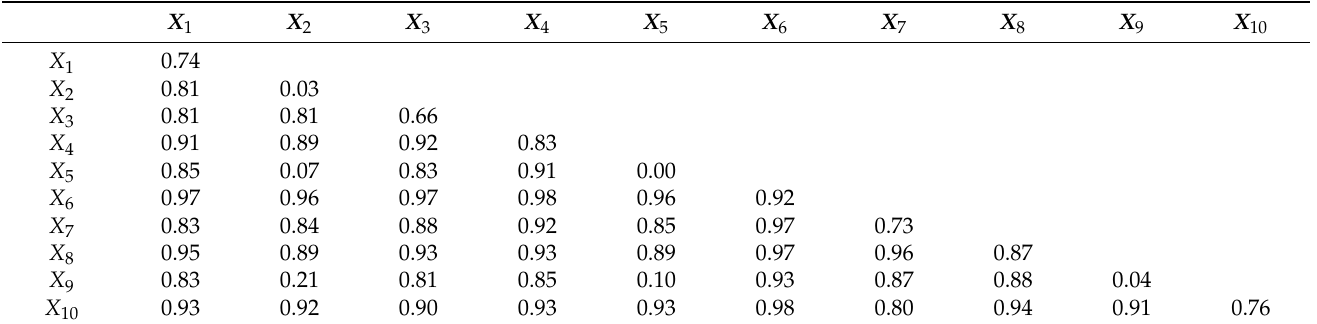
Table 5. Factor interaction analysis of the doctor.